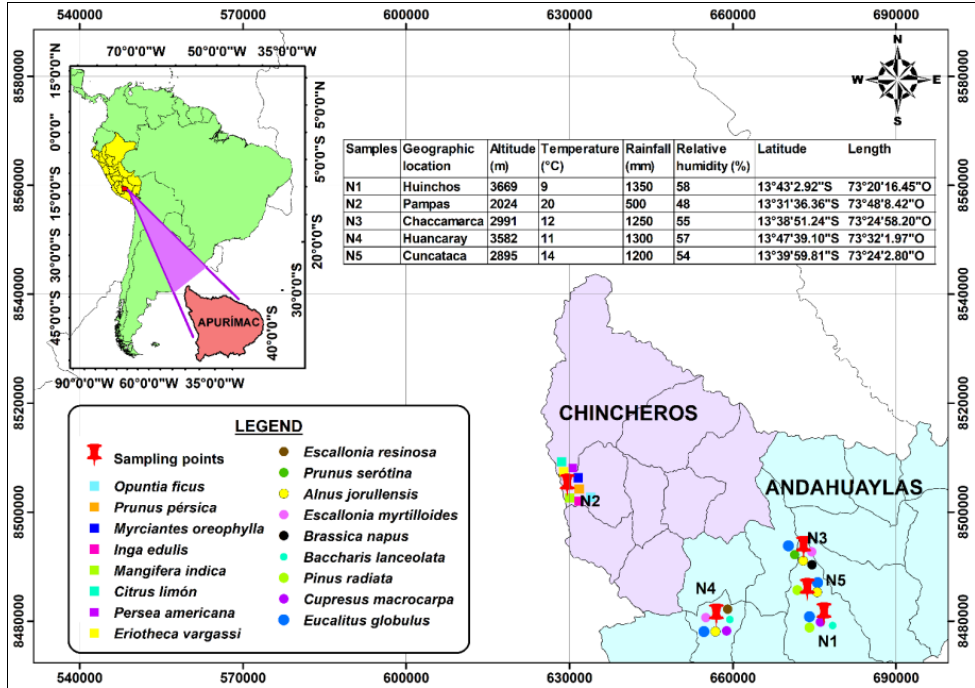
Figure 1. Geographical location of the raw natural multi-floral propolis collection sites.